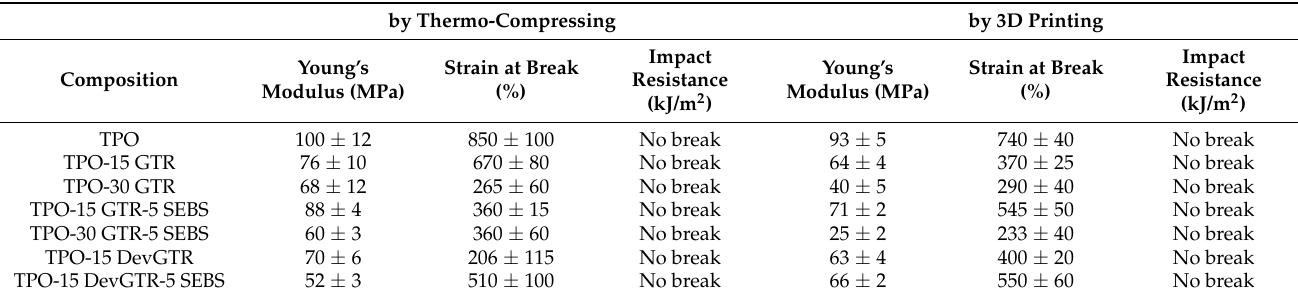
Figure 9. Images of 3D printed specimens after tensile and impact tests.